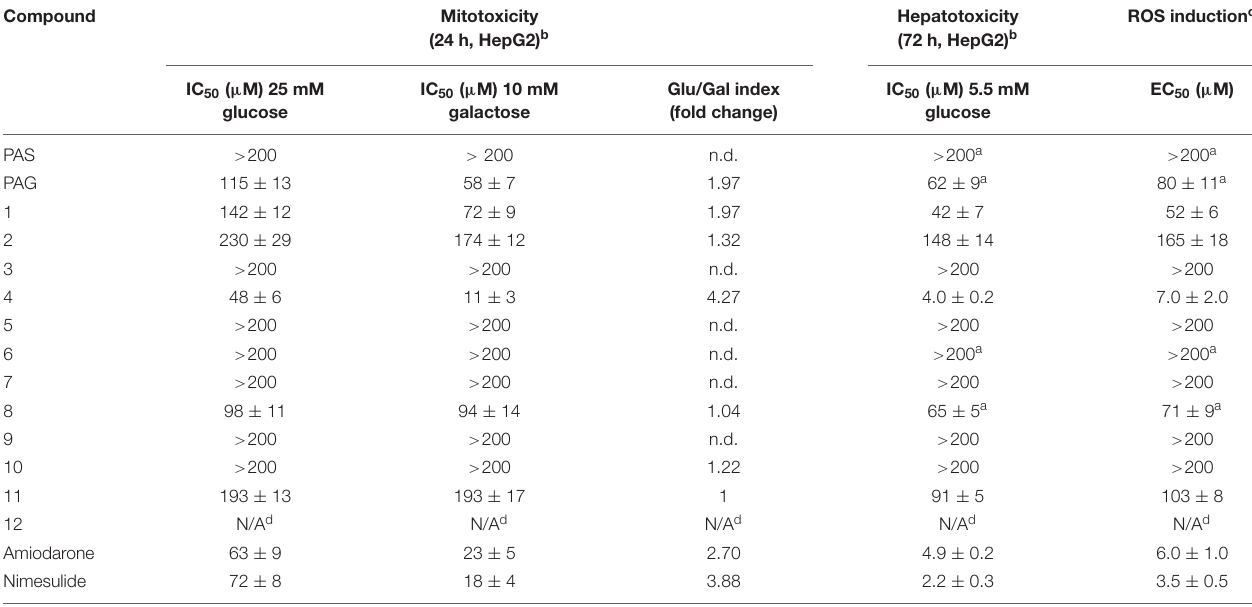
TABLE 3 | Mitotoxicity, hepatotoxicity and ROS induction in HepG2 cells of compounds PAS, PAG ( Figure 1 ), and 1–12 ( Figure 2 ).